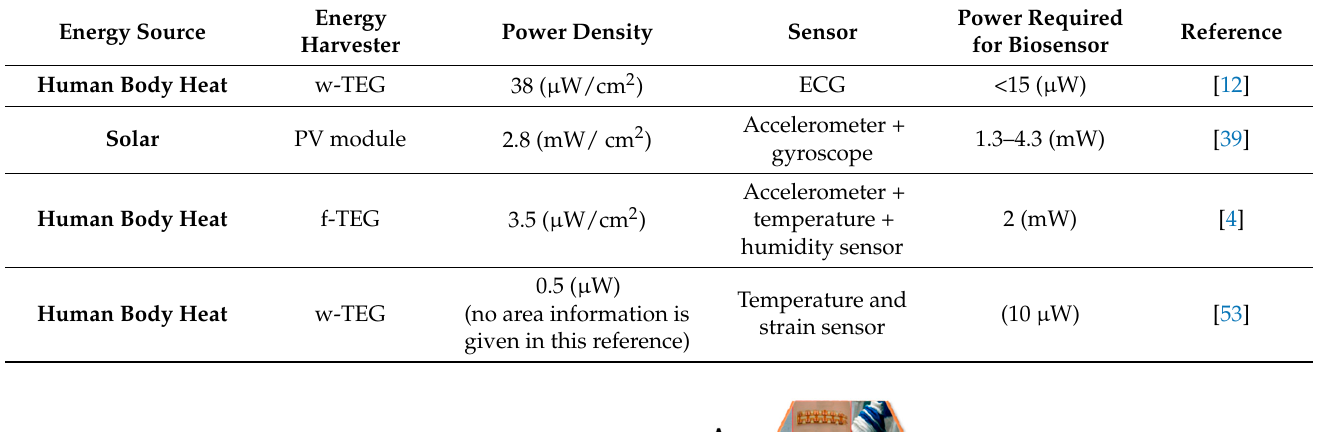
Table 1. Energy budget for WTEG-based self-powered biosensors.